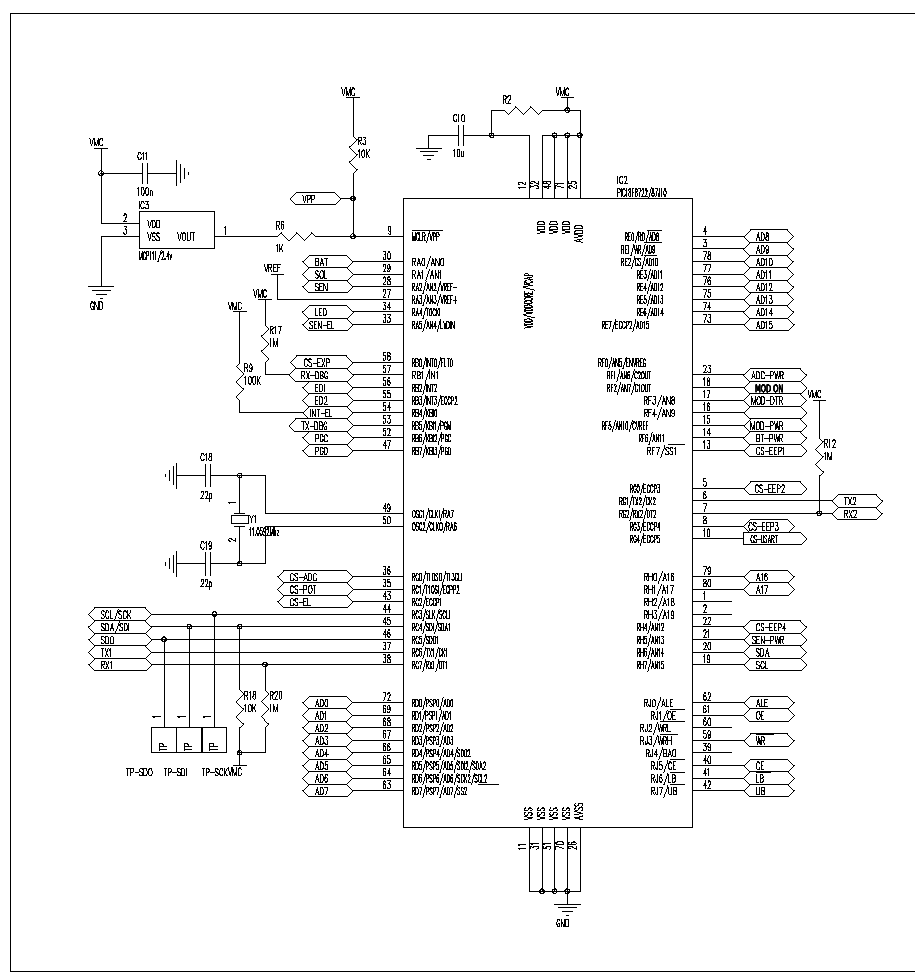
Figure 3. Circuit schematic of the microcontroller module. The center portion is the microcontroller used to control DatalogV1 operation, and the center-left is the crystal oscillator used for setting the